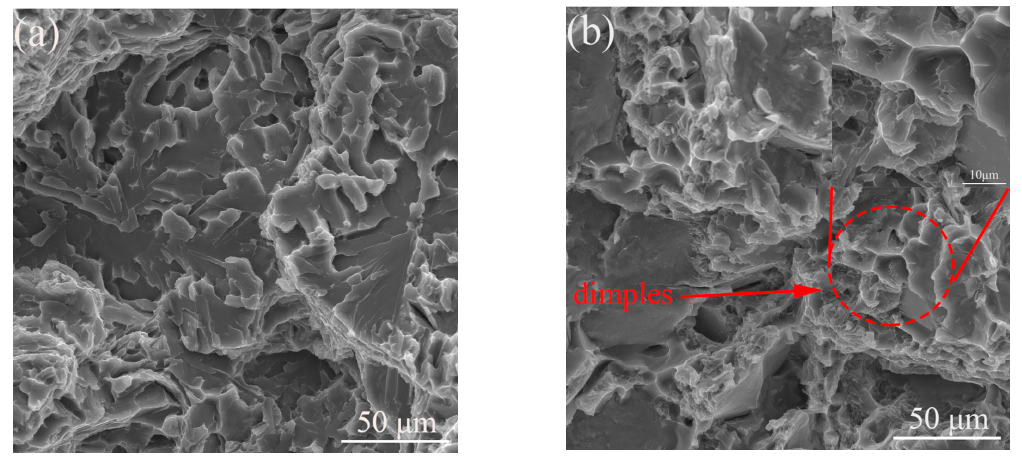
Figure 10. Fractographs of the tensile samples of ADC12 alloy without Yb addition and with 0.8 wt % Yb addition: ( a ) unmodified; ( b ) 0.8 wt % Yb.